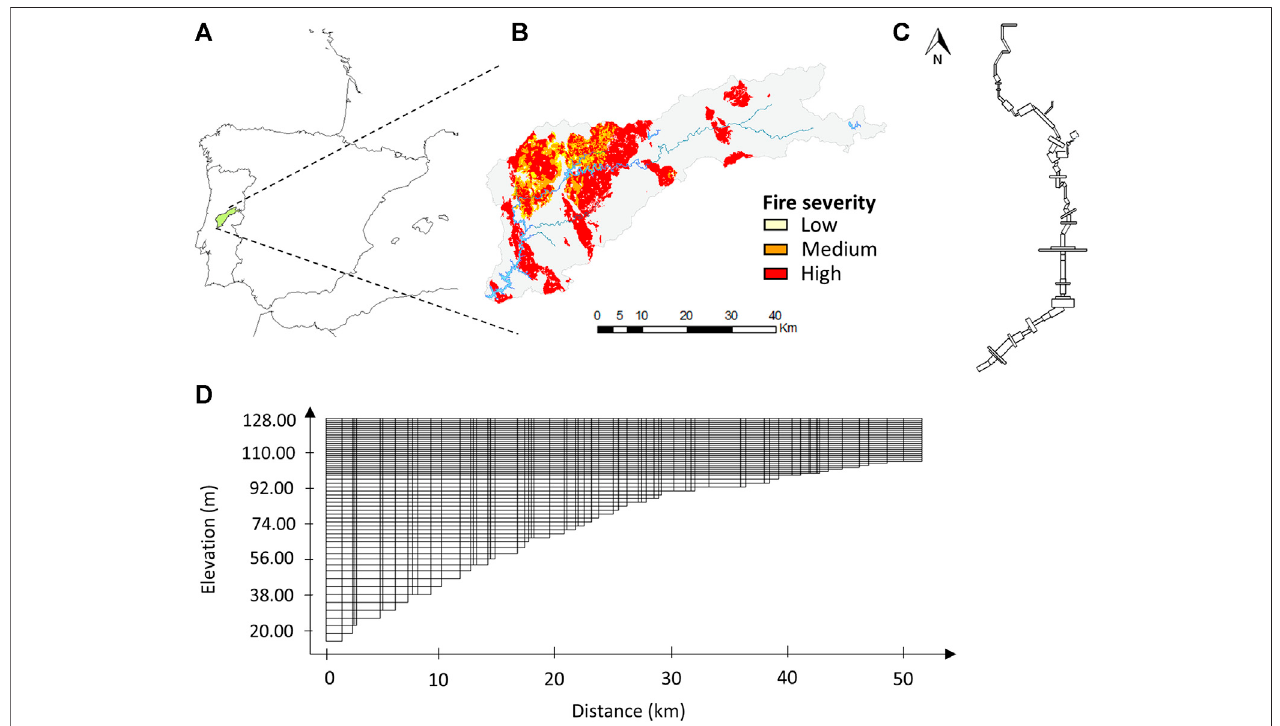
FIGURE 1| (A) Study area location, (B) 2017 burned area extension and fi re severity in river Z ˆ ezere watershed, (C) plan view and (D) longitudinal pro fi le ofCastelo de Bode